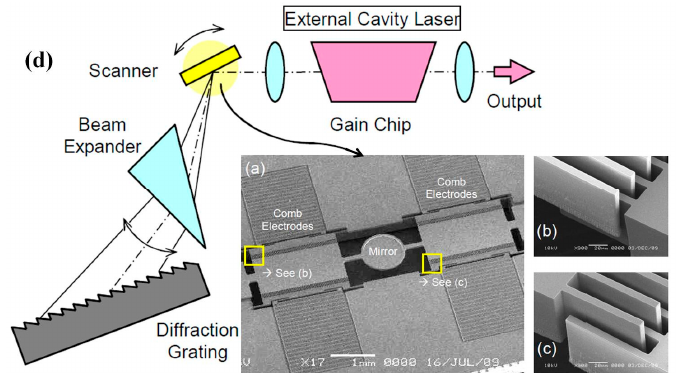
Figure 3. High speed MEMS scanner for a 140-kHz wavelength tunable-laser in Sweep Source (SS)-OCT: ( a ) SEM images; and side-bank vertical combdrives in detail ( b , c ). ( d ) System configuration of external cavity tunable laser with the MEMS scanner which replaces the conventional bulky polygon scanner (Reproduced with permission from IEEE [37]).